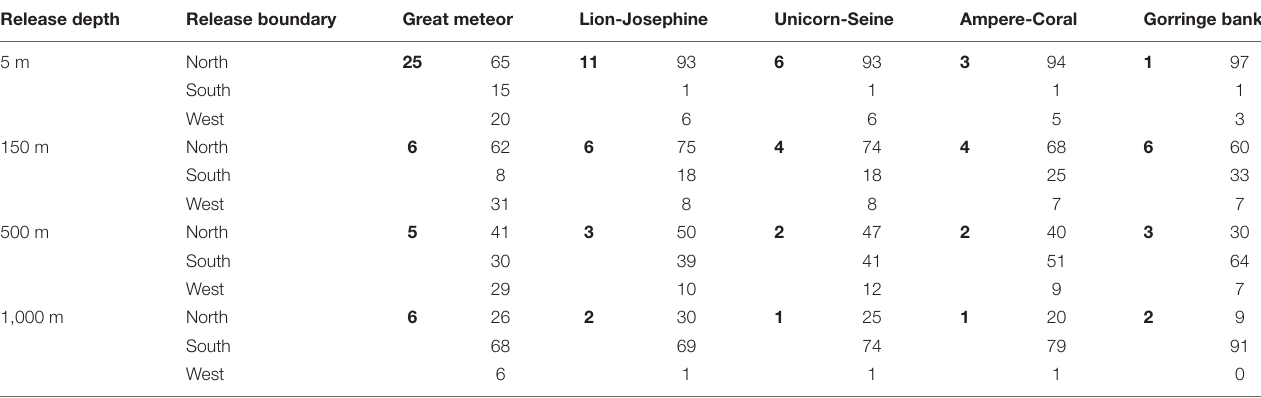
TABLE 2 | Percentage of particles released along the domain boundaries (NB, WB, and SB) that were captured by the different sink boxes (in bold), with the corresponding percentages from each boundary, at each release depth, during the particle retention study. Release depth